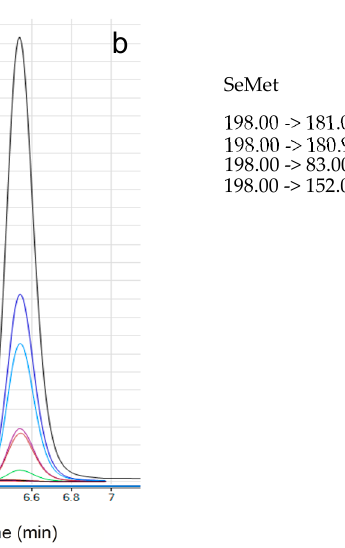
Figure 3. Chromatogram registered for extract of yeast C. utilis ATCC 9950 (transitions precursor ion → product ion) ( a ) and SELM − 1 (selenium-enriched yeast certified reference material) ( b ) by UHPLC-ESI-QqQ-MS (the colors correspond to the intensity of the SeMet compounds, Supplementary Materials, Figure S8).